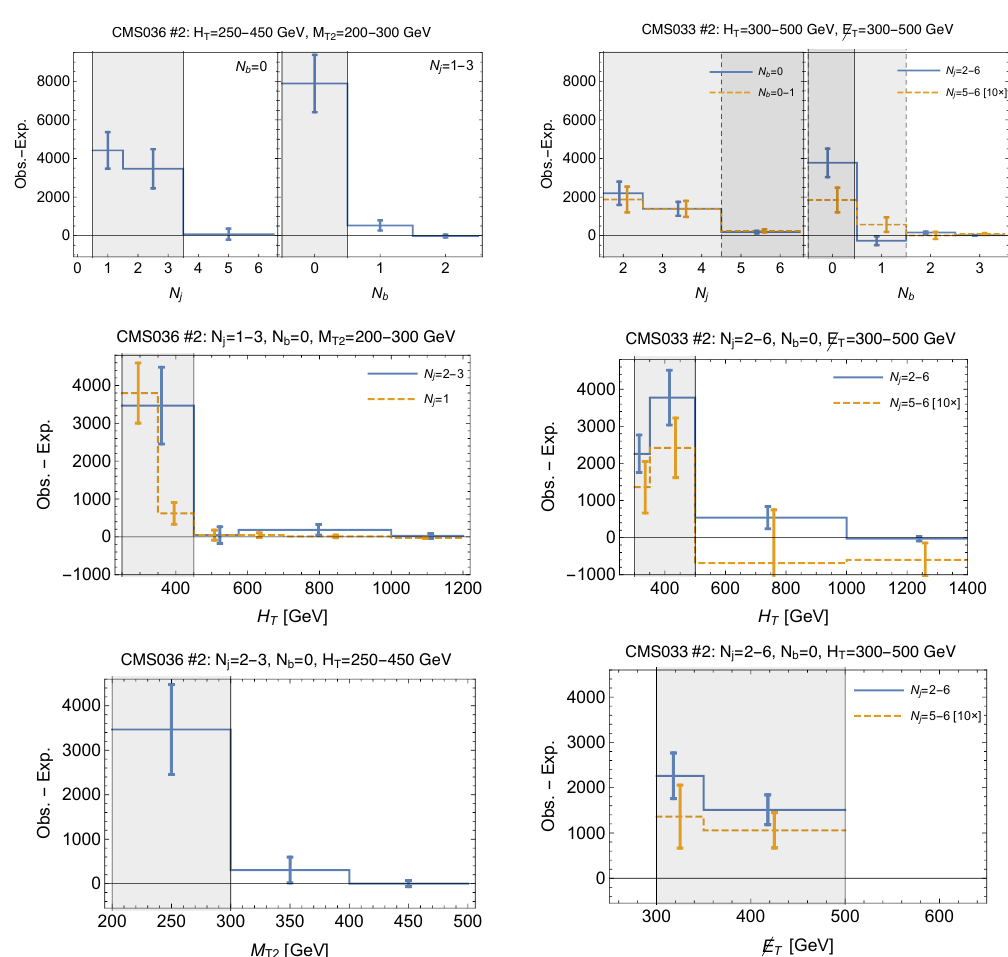
Figure 2 . Distributions of the residuals (observed minus expected counts) for the broadly compat- ible excesses of CMS036 and CMS033, ROIs #2 in table 1 and table 2, with error bars denoting the uncertainty, as explained in the text. The left column shows kinematic distributions for CMS036 ROI #2 while the right column displays CMS033 ROI #2. Within each column, from top to bottom we show the N j ; N b ; H T and M T 2 ( =E for CMS033) distributions of the signi(cid:12)cant aggregation T (shaded in gray) and the neighboring bins in that direction in kinematic space. Solid and dashed lines show di(cid:11)erent components of each aggregation, as labeled in the legends. See text for more